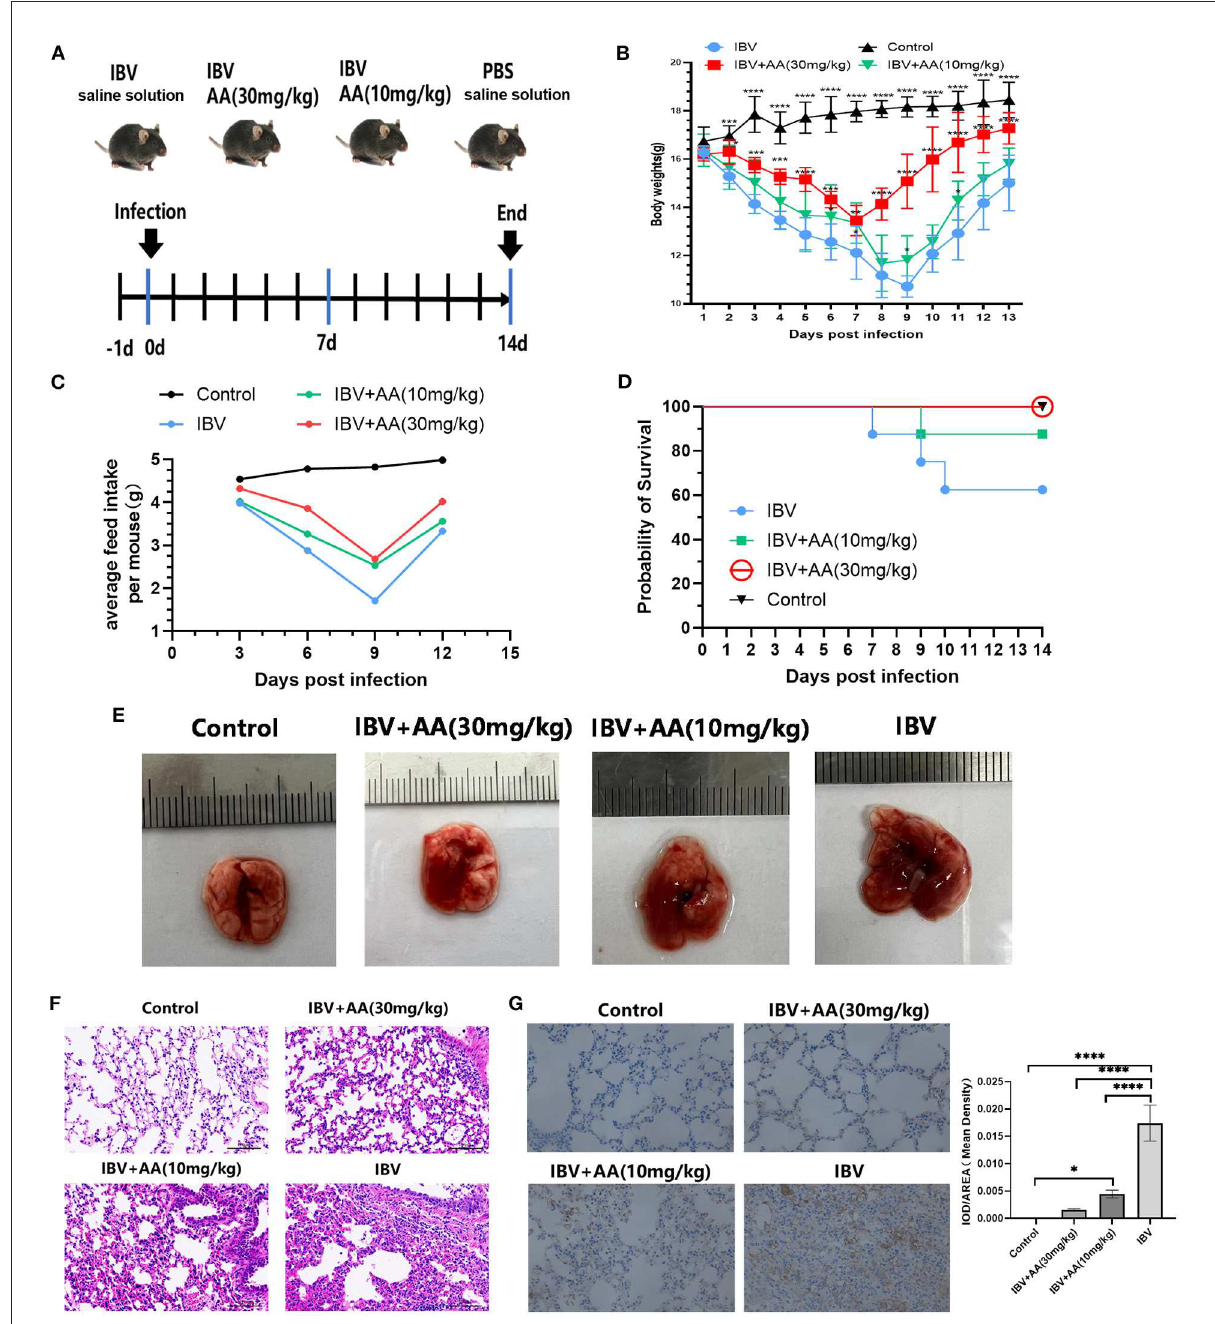
FIGURE4 Antiviral effects of Atractyloside A against IBV infection in vivo . (A) Efficacy evaluation of Atractyloside A and infection procedure in mice. Changes in body weight (B) and feed intake (C) after infection in mice. (D) The survival rate of mice after infection. (E) Lung tissue of mice infected with IBV in the different groups. H&E (F) and immunohistochemical (G) analysis of lung tissue after infection. The results are presented as mean ± standard deviation (* p < 0.05, ** p < 0.01, *** p < 0.001, and **** p < 0.0001).